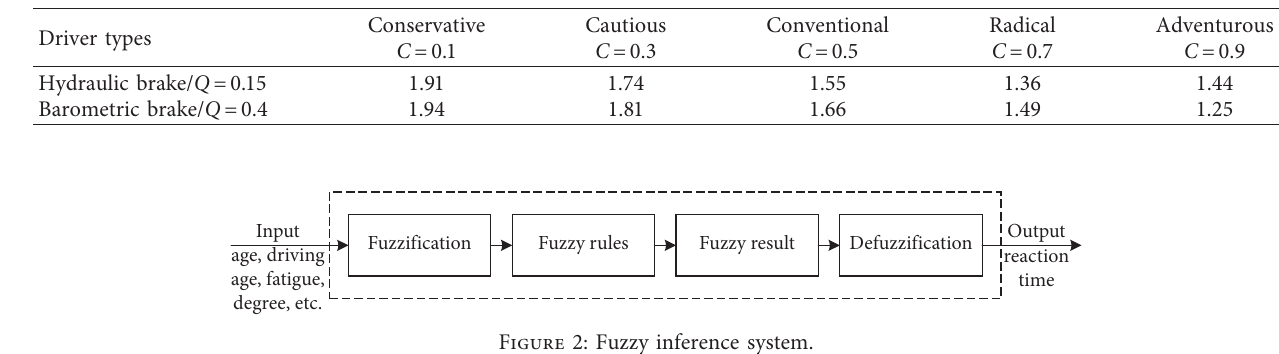
Table 1: Reaction time of different types of drivers (s).